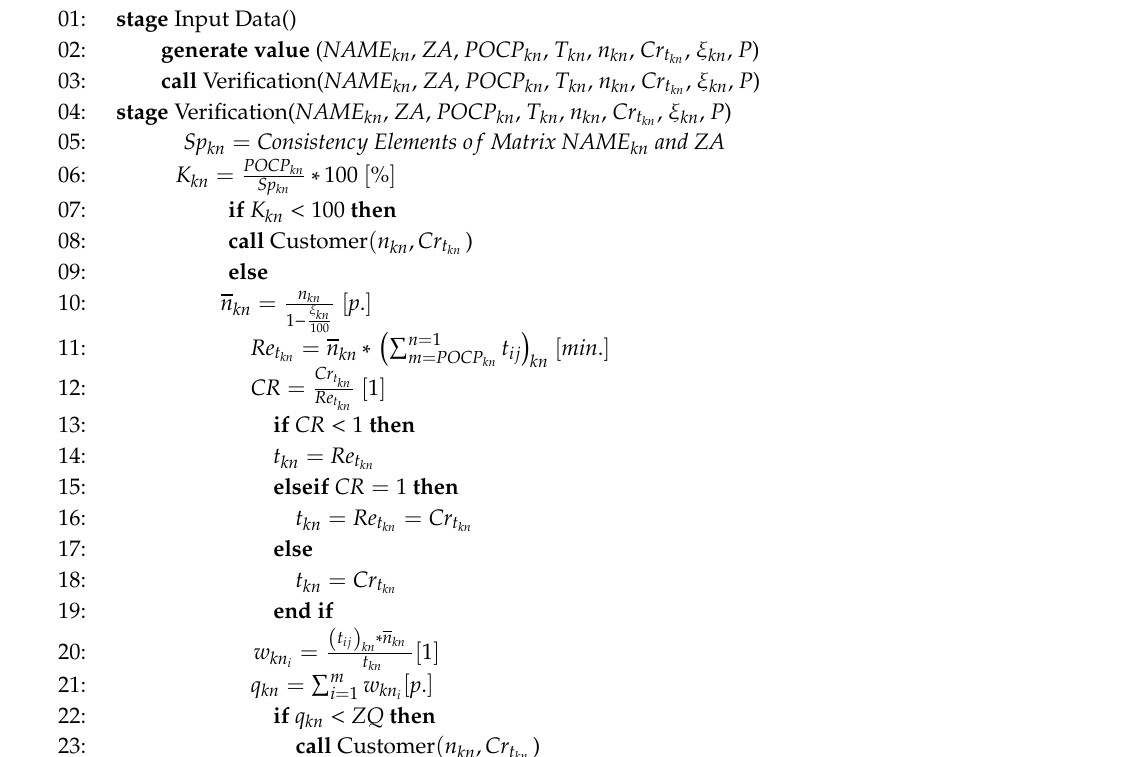
Algorithm 1 Algorithm of input data stages and verifying the capacity and operational